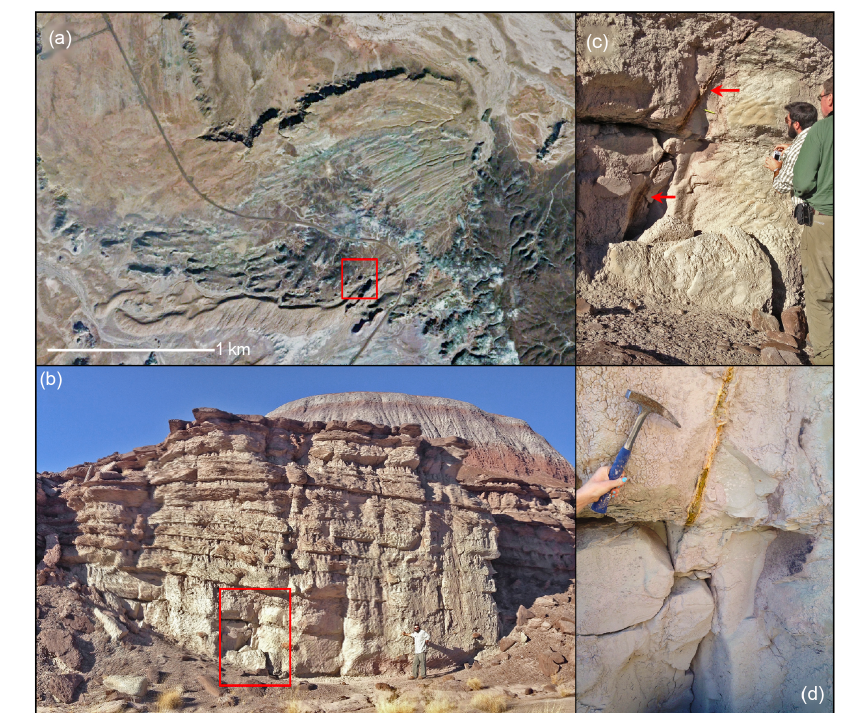
Figure 10. Details of Newspaper Rock facies which is absent in cores: (a) GoogleEarth image of scrollbars (best developed in middle of image), red box is location of photo in (b) ; (b) tilted beds of greenish ripple-crosslaminated sandstone and siltstones looking north at scroll- bar (point bar) at 34.949 ◦ , − 109.776 ◦ with + 2m upright, plant stem (? Equisetities ) in growth position in red box enlarged in (c) indicative of extremely fast accumulation ( ∼ + 1m/season) – Morgan Schaller for scale; (c) plant stem (? Equisetities ) in growth position (portion between arrows) is enlarged in (d) – beds dip from right (west) to left (east) with faint left-inclined streaks being aligned lee faces of climbing ripples; (d) close up of stem in growth position, hammer is 28cm long – yellow color is due to weathered pyrite.